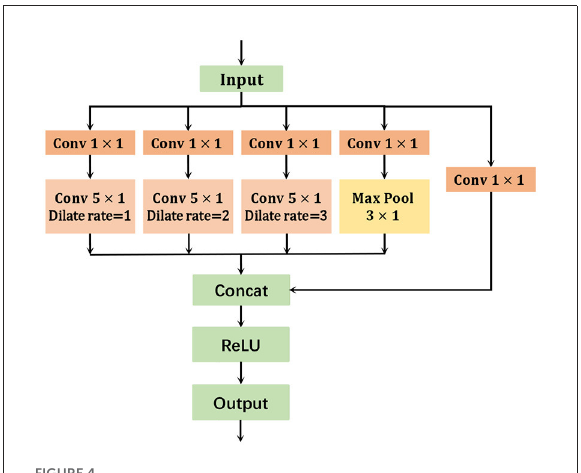
FIGURE4 Multi-scale temporal graph convolution